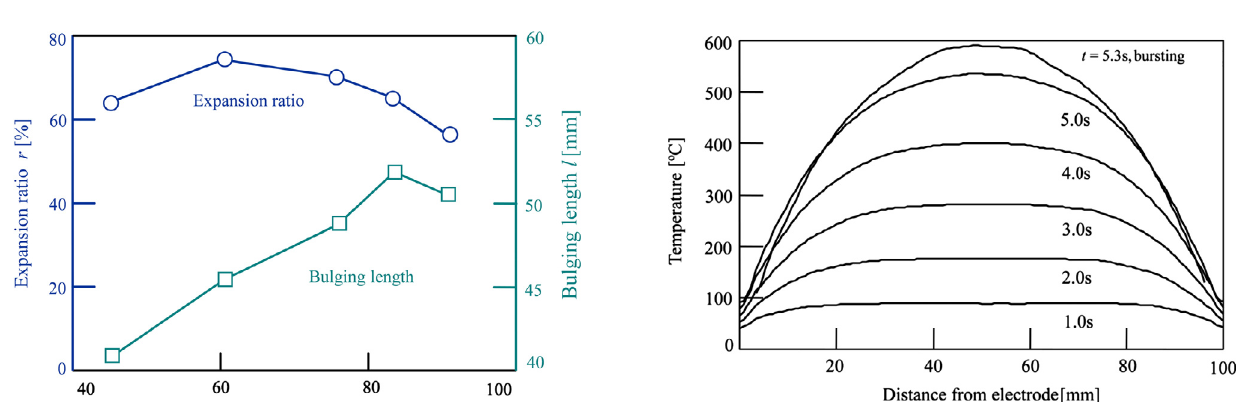
Figure 10. Distributions of temperature on surface of tube in hot bulging for J = 76 A/mm 2